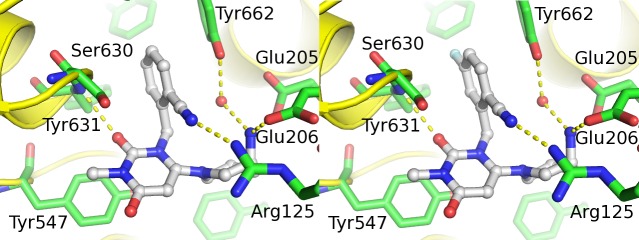
Comparison of x-ray crystal structures of inhibitors bound to DPP-4.Comparison of x-ray crystal structure of inhibitors bound to DPP-4 for alogliptin (left panel) and trelagliptin (right panel).